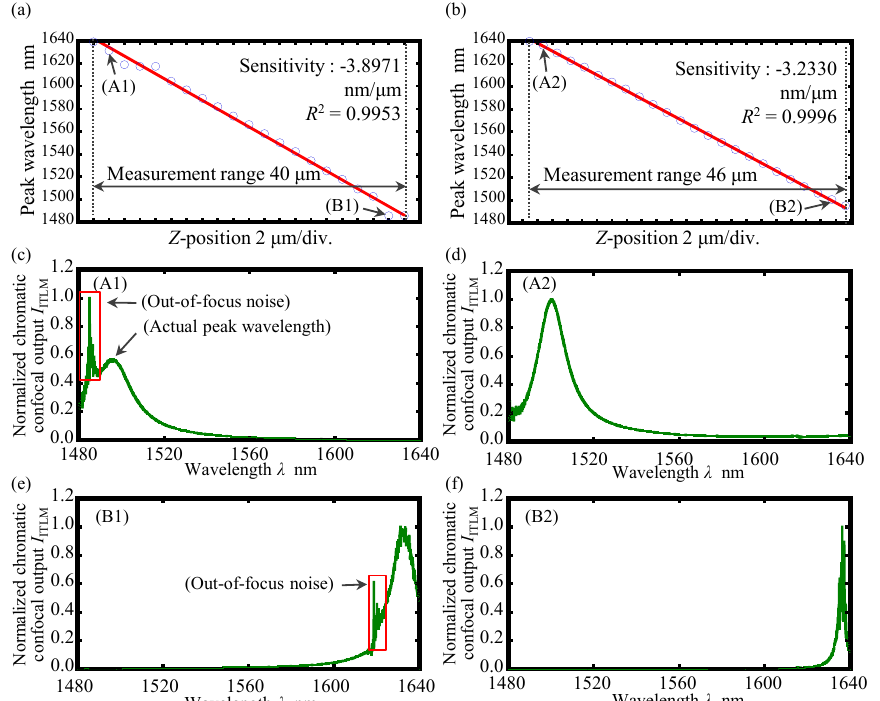
Figure 7. Noise reduction performances in the two methods. ( a ) Measurement range of the conventional defocus differential method; ( b ) measurement range of the proposed off-axis differential method; ( c ) normalized chromatic confocal output I ITLM in (A1) position; ( d ) normalized chromatic confocal output I ITLM in (A2) position; ( e ) normalized chromatic confocal output I ITLM in (B1) position; ( f ) normalized chromatic confocal output I ITLM in (B2) position.